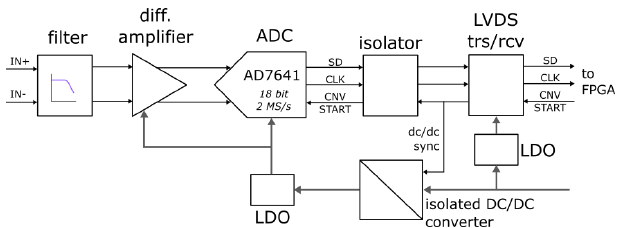
Figure 17. Block schematic of the ADC module.